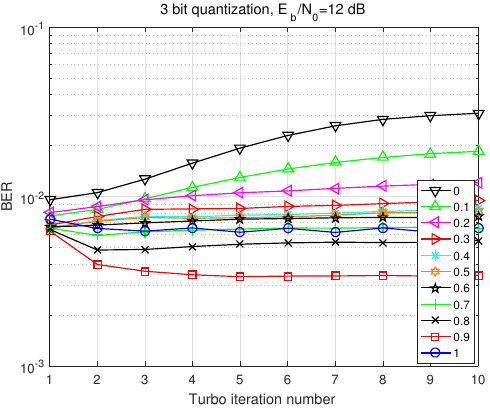
Figure 5. BER performance versus Turbo iteration number at E b / N o = 12 dB for different values of α .